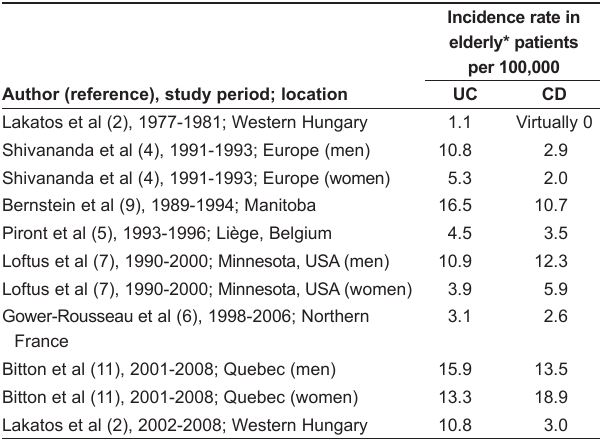
Table 1 Incidence rates of ulcerative colitis (UC) and Crohn disease (CD) in elderly